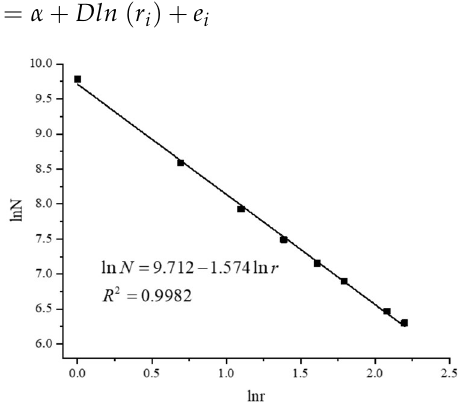
Figure 2. Calculation of fractal dimension.